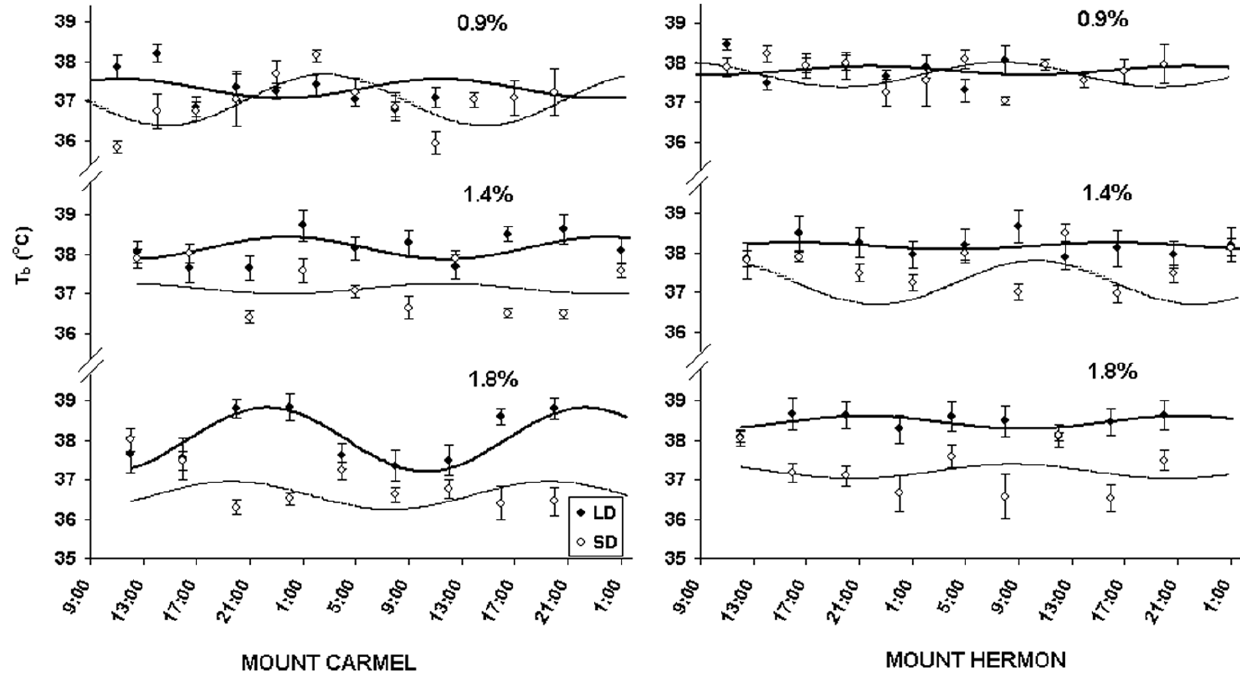
Figure 3. Body temperature daily rhythms. Body temperature ( T b : u C) daily rhythms of short day ( SD: open circles, continuous line) and long day ( LD: closed circles, bold line) acclimated A. mystacinus at salinity regimes of 0.9, 1.4 and 1.8% from Mount Carmel and Mount Hermon. Curves denote best-fit cosine functions [54]. Error bars denote standard errors.